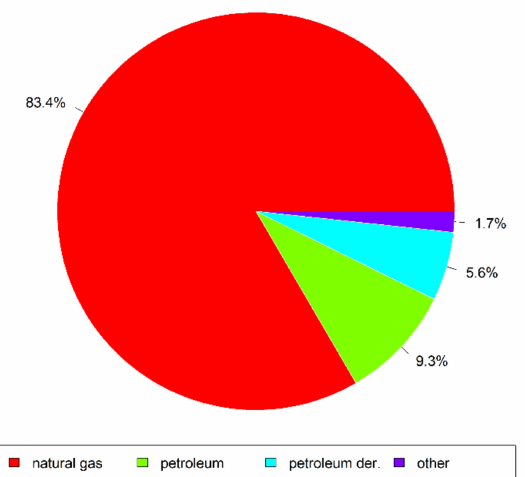
Figure 2. Share of hydrocarbons in Turkmenistan’s exports in 2018. Source: